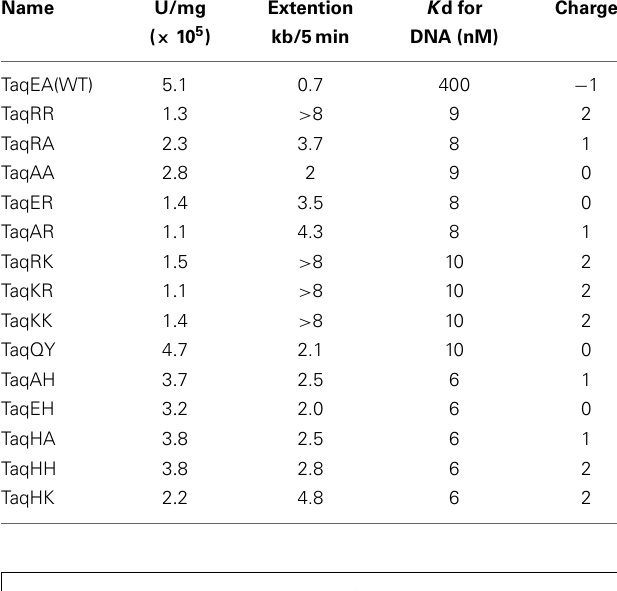
Table 4 | Properties of the mutant Taq polymerase.